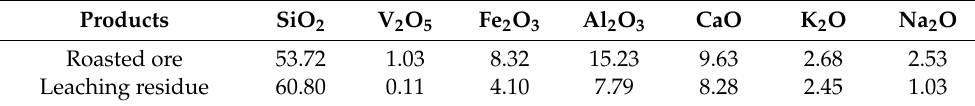
Table 3. Main chemical composition analysis of leaching residue